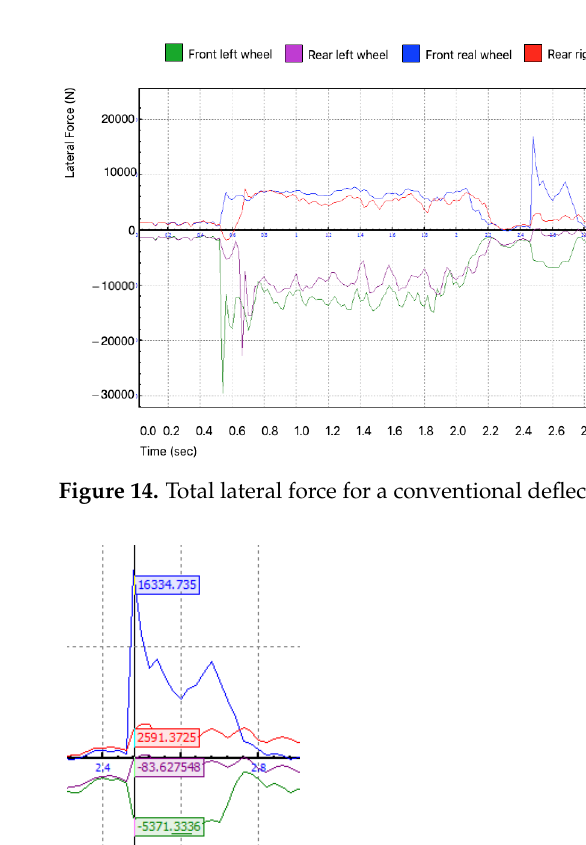
Figure 15. Maximum values of lateral force.